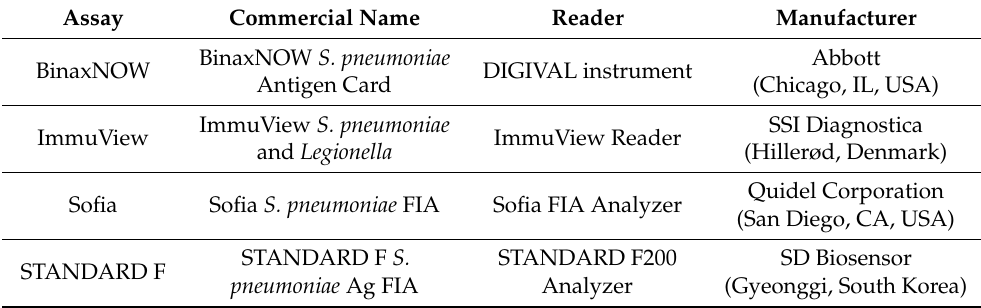
Table 1. Streptococcus pneumoniae urine antigen assays evaluated in the